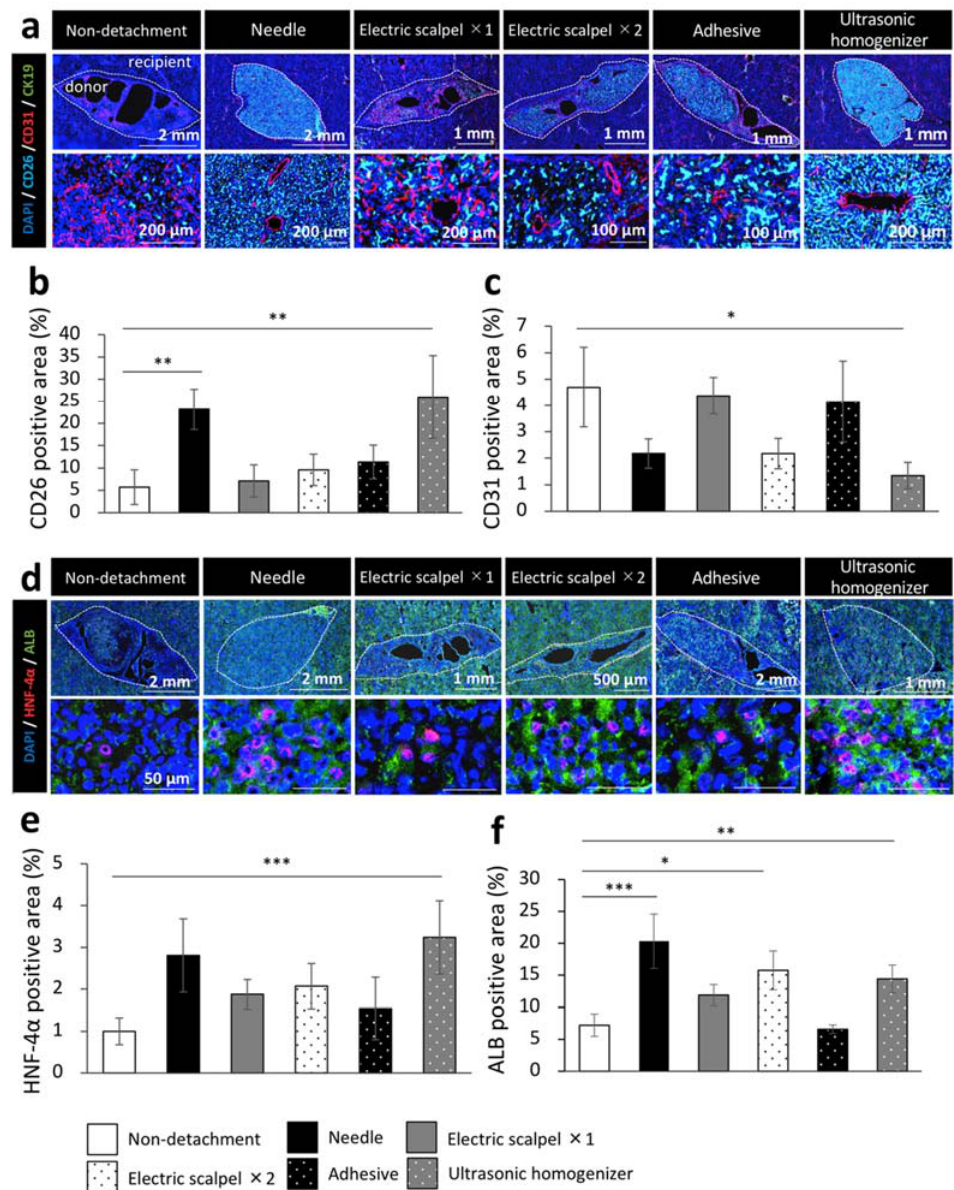
Figure 5. Immunohistochemistry of the fetal livers transplanted using different detachment methods. ( a , d ) Immunohistochemical staining for DPPIV (CD26, light blue), vascular endothelial cell marker (CD31, red), bile duct epithelial cell marker (CK19, green), hepatocyte nucleus marker (HNF-4 α , red) and hepatocyte marker (albumin, green). ( b , c , e – f ) Areas positive for CD26, CD31, HNF-4 α , or albumin of the transplanted tissues were measured at three weeks after transplantation (non-detachment, n = 6; needle, n = 4; electric scalpel ×1, n = 6; electric scalpel ×2, n = 4; adhesive, n = 4; ultrasonic homogenizer, n = 4). The data are shown as the mean ± standard error. * p < 0.05, ** p < 0.01, *** p < 0.001 versus non-detachment group by non-repeated measures analysis of variance with Bonferroni correction.